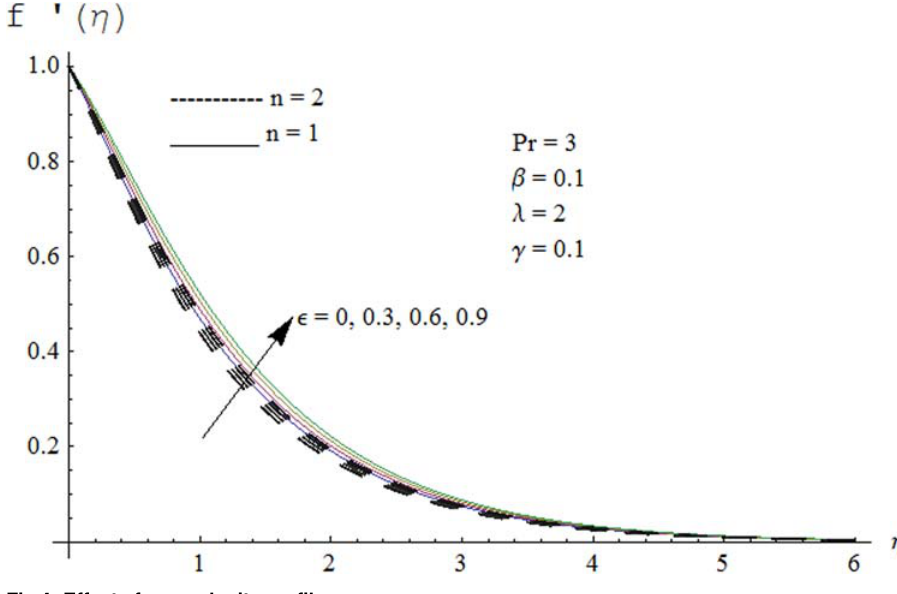
Fig 4. Effect of ε on velocity